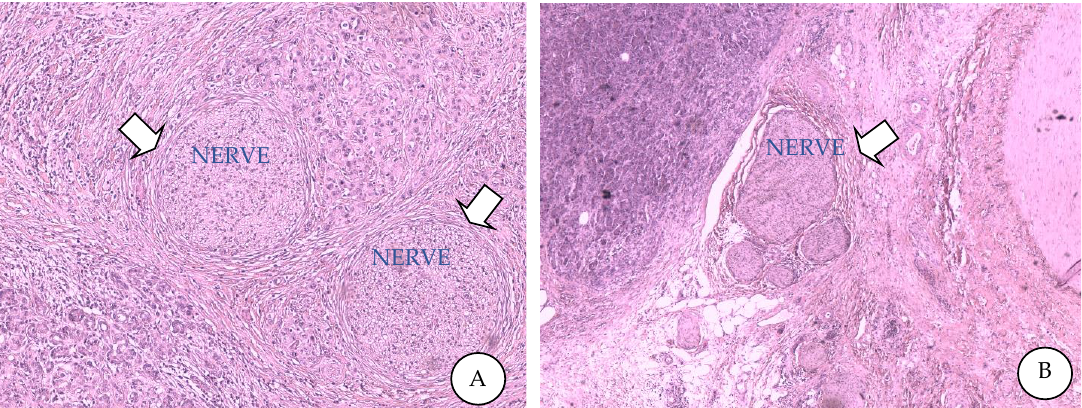
Figure 1. Perineural invasion from high-grade PDAC with desmoplastic and lymphocytic reaction into the surrounding stromal tissue ( A ). Hypertrophic nervous fibre bundle in the parenchyma away from PDAC cells ( B ).